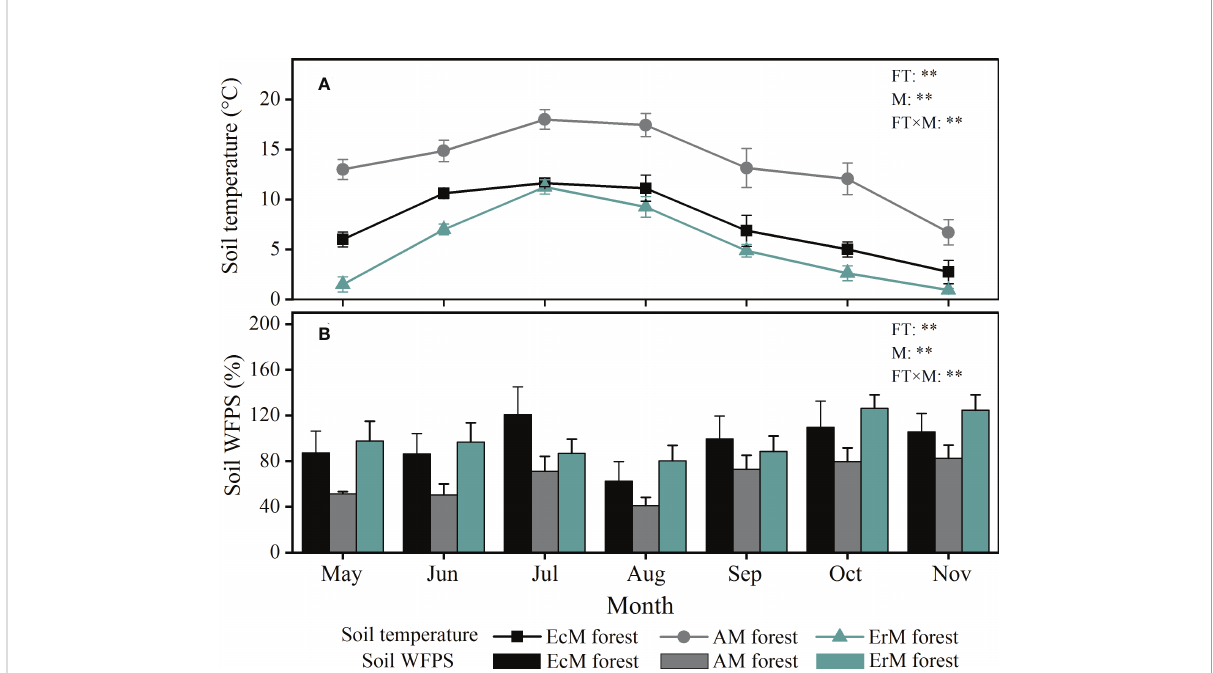
FIGURE 1 Monthly variations in soil temperature (A) and soil WFPS (B) among three mycorrhizal forests. The vertical bars are the standard error, n=8. EcM forest, Abies fargesii var. faxoniana primary forest; AM forest, Cupressus chengiana primary forest; ErM forest, Rhododendron phaeochrysum